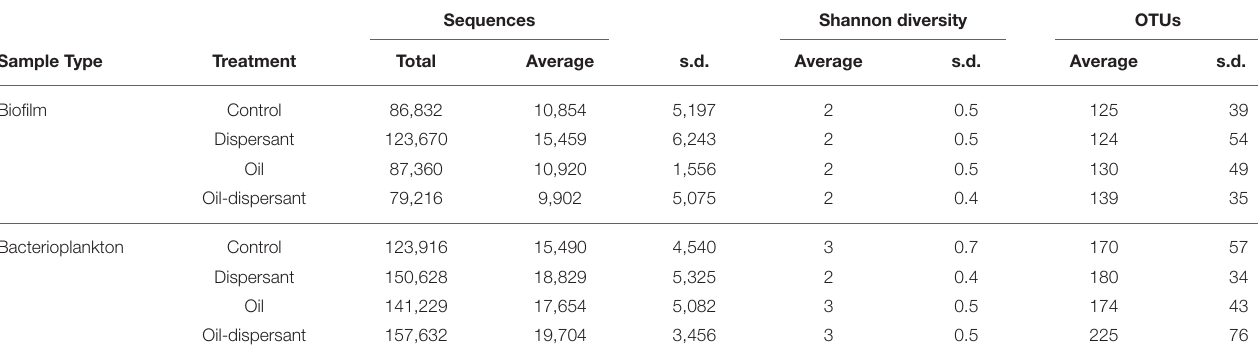
TABLE 1 | Total and average number of sequences, average Shannon’s diversity index, and average number of OTUs for microcosm carbon steel disk biofilm samples ( n = 8 per treatment) and bacterioplankton samples ( n = 16 per